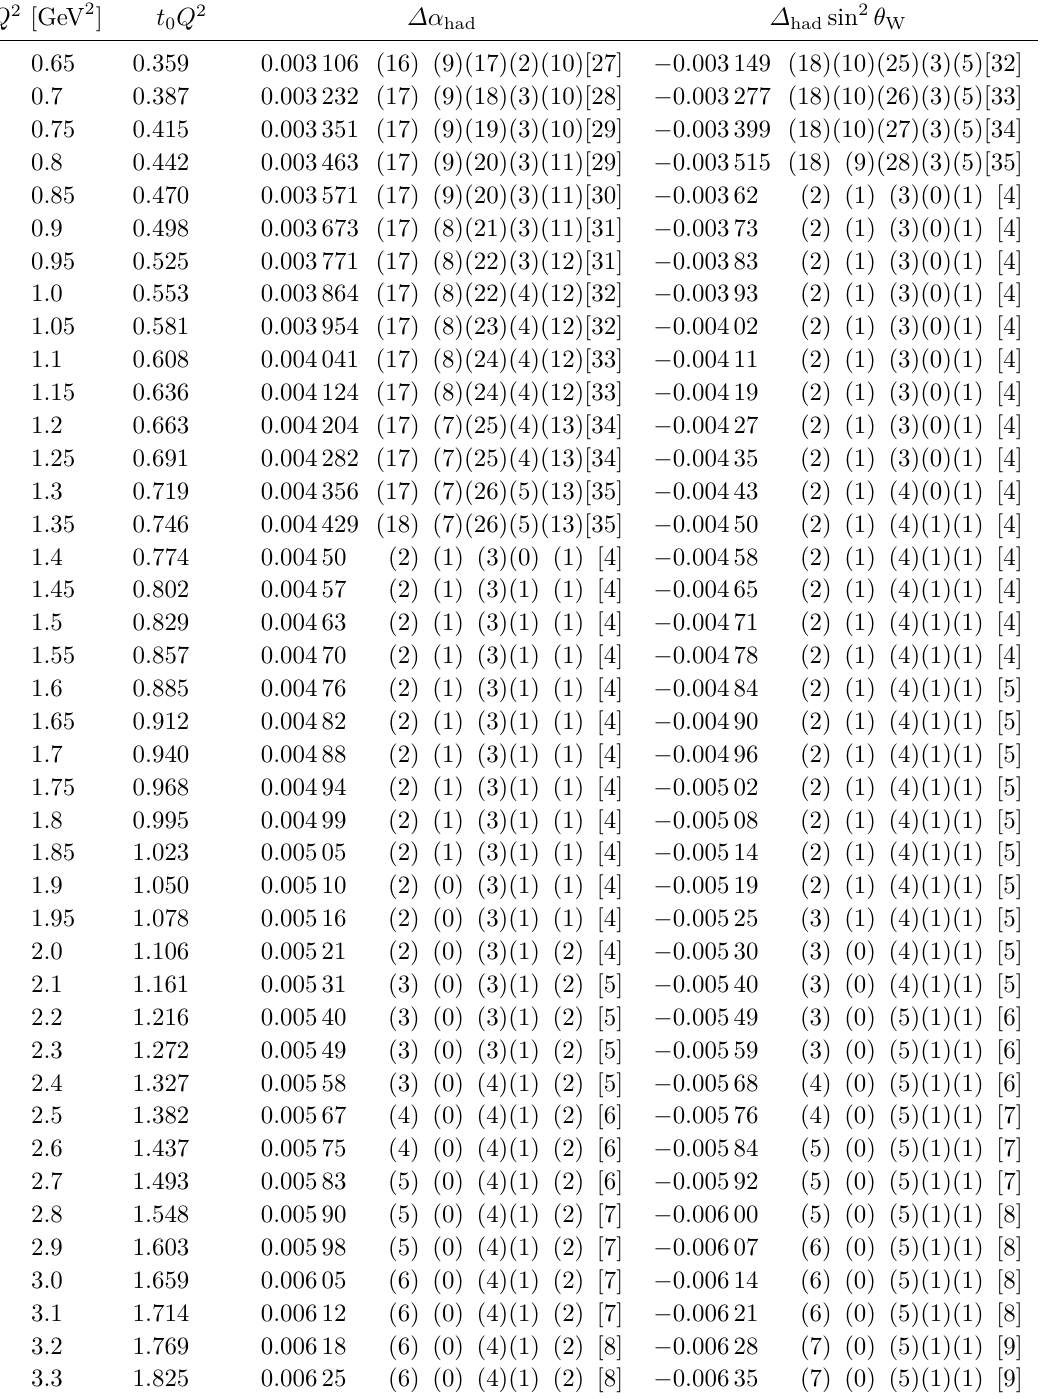
Table 13 . Results for the total HVP contribution to the running of α and sin 2 θ W extrapolated to the physical point for all the values of Q 2 sampled. Following the statistical error, and the systematic errors from varying the fit model estimated, scale-setting and missing charm sea-quark loops, the fifth uncertainty is the systematic error from missing isospin-breaking effects (see section 4.2.3). The final uncertainty, quoted in square brackets, is the combination of the previous ones